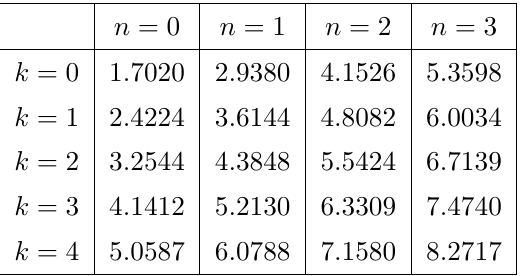
Table 1. The spectrum of the gravitational perturbation !=M KK